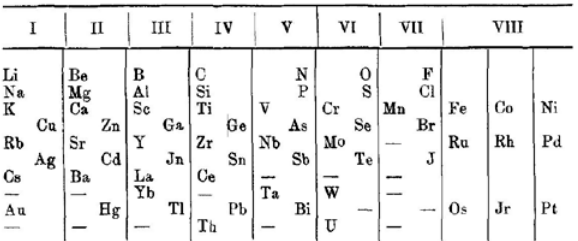
Figure 8. One of the last presentations of Meyer‘s arrangement of elements in 1893. Scan from L. Meyer, Ber. Dtsch. Chem. Ges. 1893 , 26 , 1230–1250, here